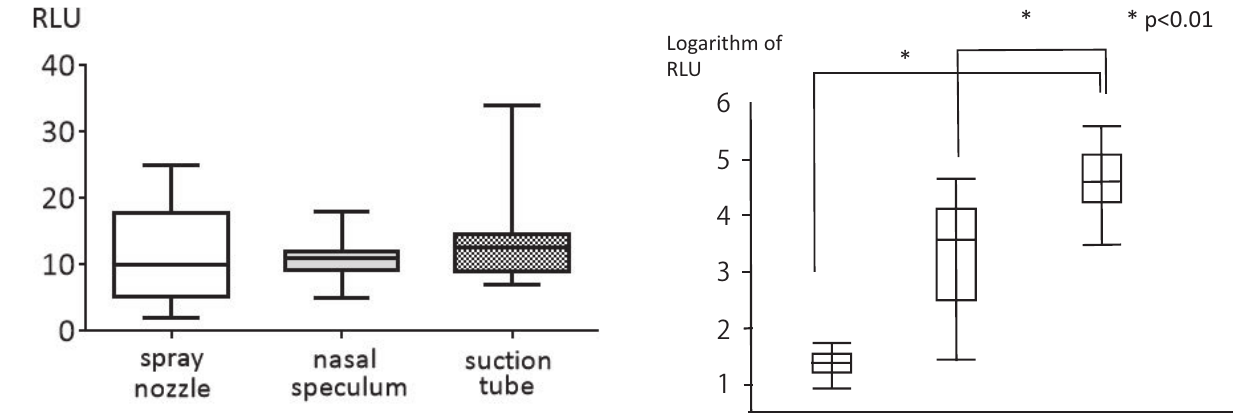
Increases in RLU scores of spra y nozzles w ere statisticall y